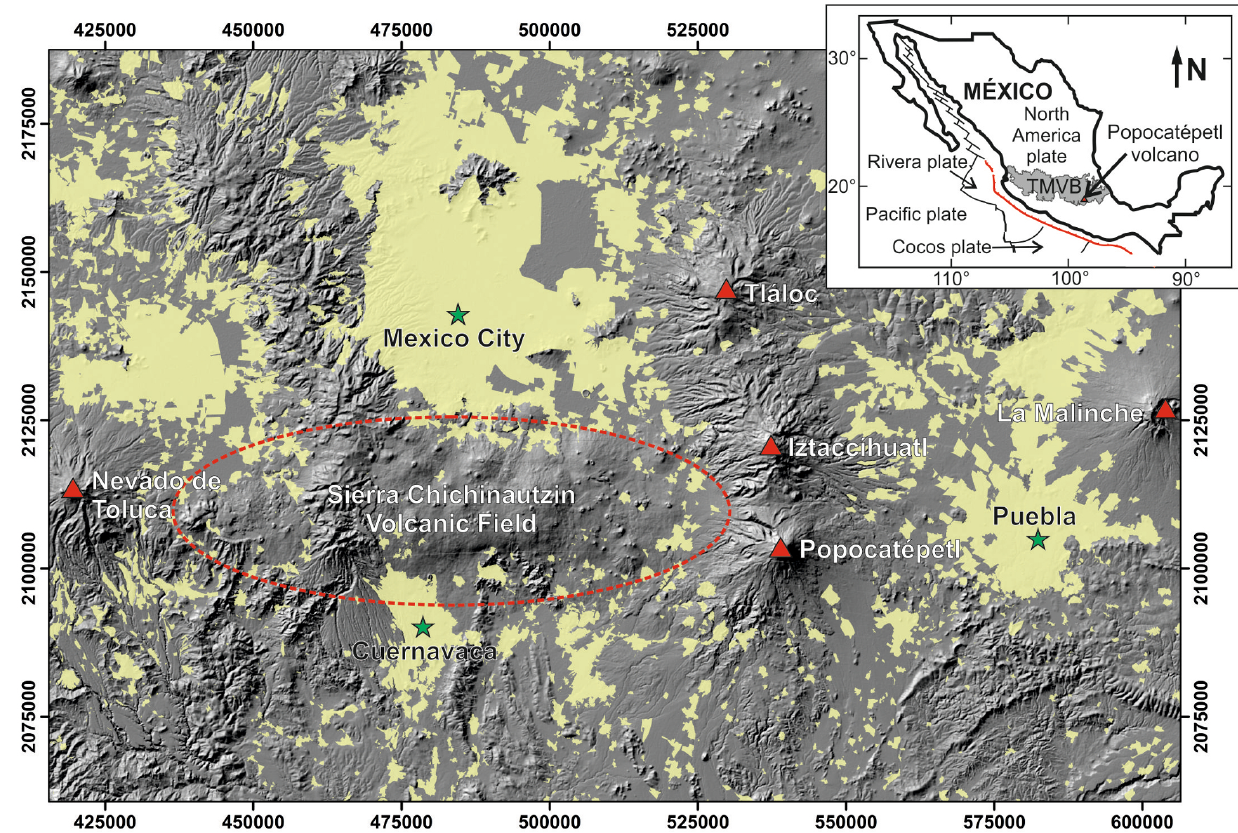
Figure 1: Location of the Popocatépetl Volcanic Complex (PVC) in the eastern part of the Central Trans-Mexican Volcanic Belt (TMVB). Popocatépetl is the youngest volcanic complex in a N–S trending chain including Iztac- cíhuatl and Tláloc. Populated areas are shaded in yellow, and green stars denote major population